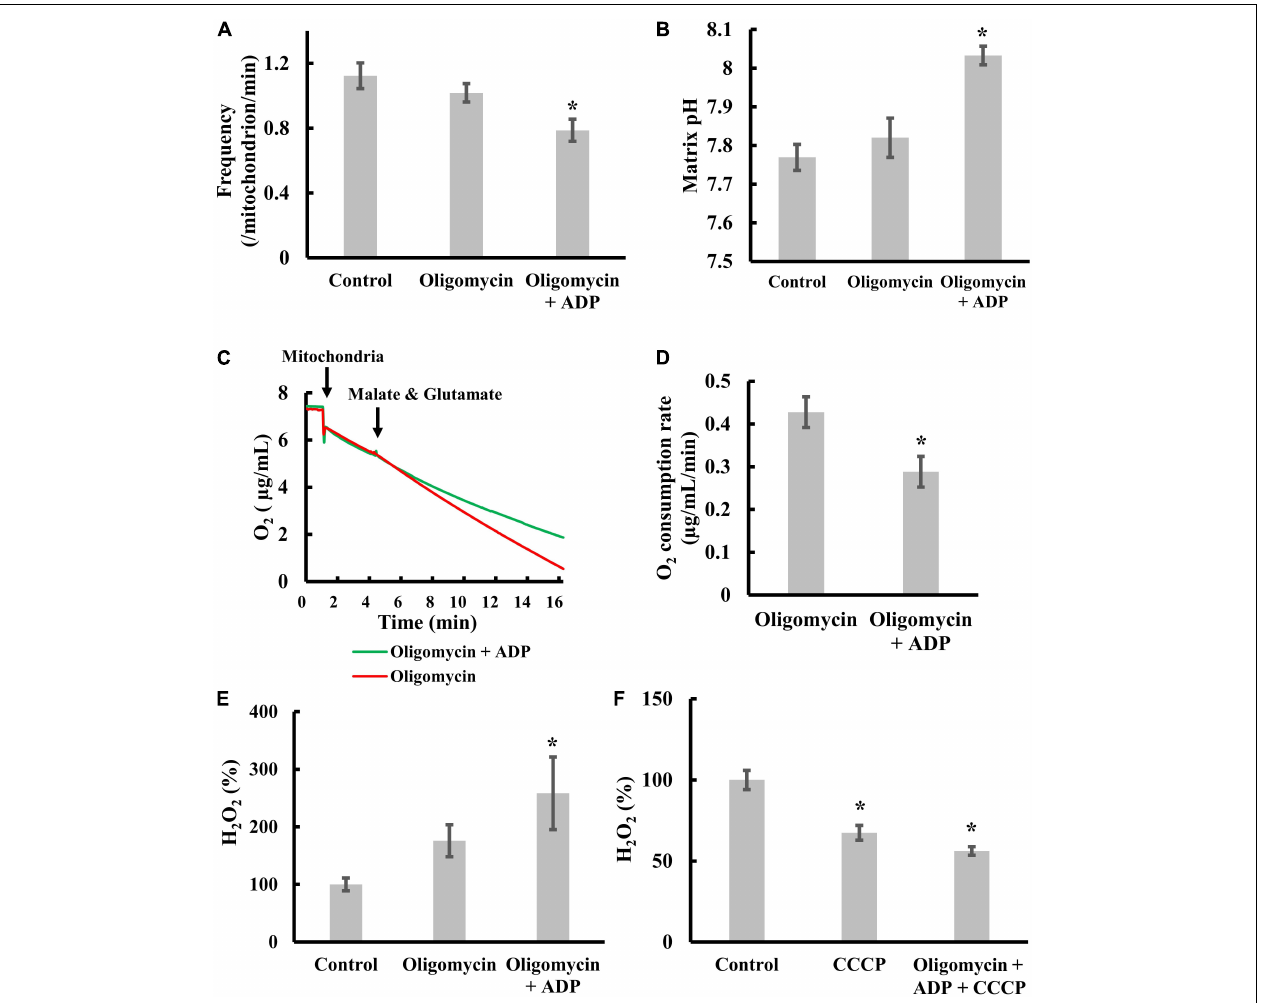
FIGURE 4 | Effects of transient depolarization on matrix pH, electron transfer, and ROS production. Isolated mitochondria were measured in the presence of 5 mM malate and 5 mM glutamate. (A–D) Effects of ADP or oligomycin on (A) the frequency of the transient depolarizations, (B) the matrix pH, and (C,D) the respiration rate. Mitochondria were incubated for 20 min at 25 ◦ C with 5 mM ADP and 1 µ M oligomycin before measurements. (E) Effects of ADP or oligomycin on ROS production. (F) Effects of CCCP on ROS production. The H 2 O 2 production rate of control mitochondria was set to 100% for (E) and (F) . Values represent the mean ± SEM ( n > 50 for frequency and matrix pH. n = 3 for respiration and ROS). * p < 0.05 vs. control without ADP and oligomycin for (A,B,E,F) ; oligomycin for (D)